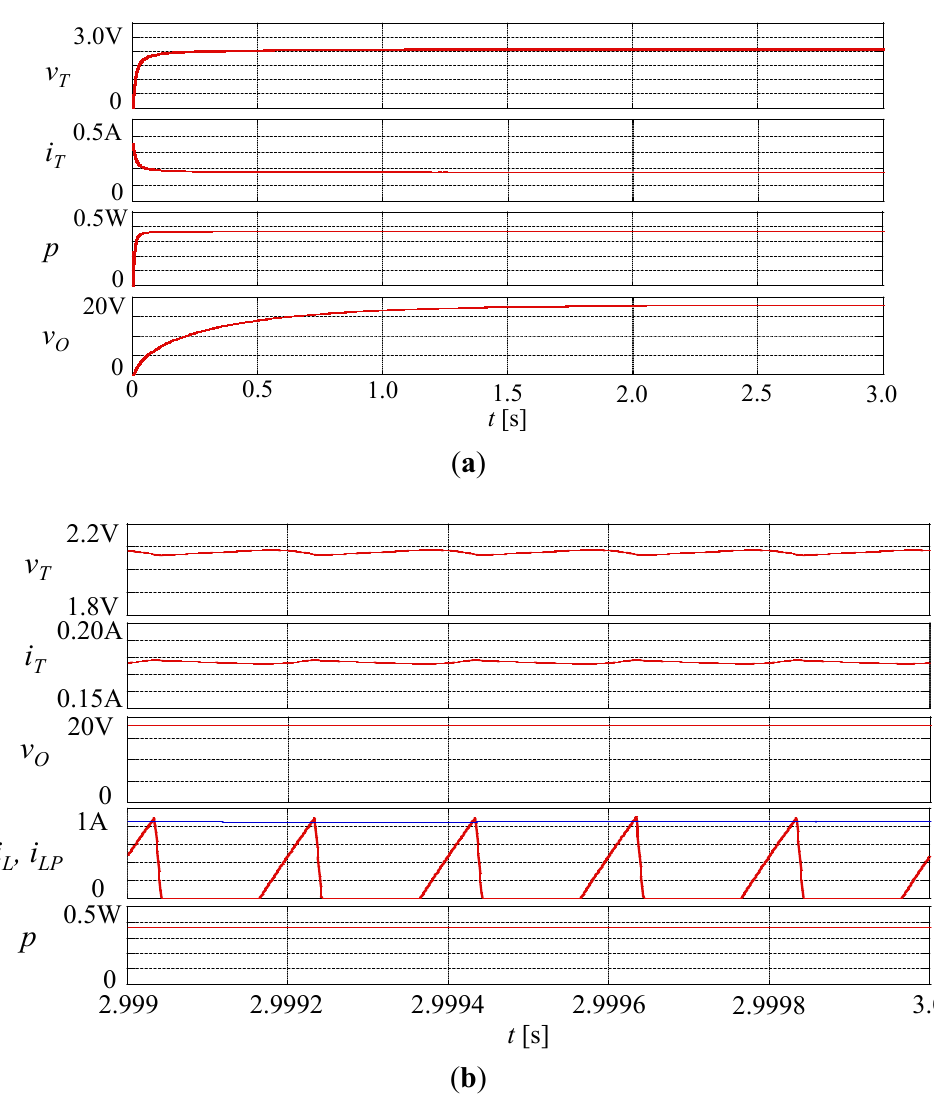
Figure 7. Simulation results by using the proposed MPPT control when the thermal difference is 35 °C. ( a ) During the starting period; ( b ) Magnified waveforms in the vicinity of 3.0